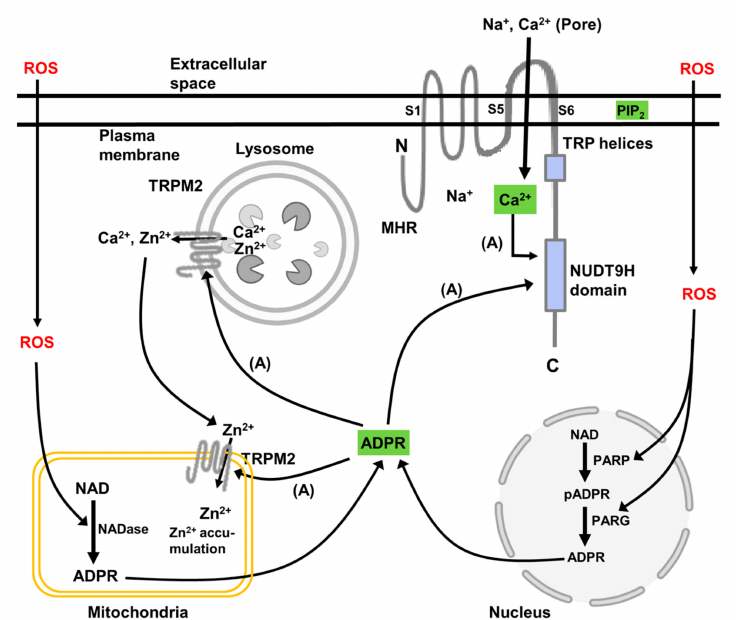
Figure 2. A schematic representation of the intracellular location of TRPM2 channels in animal cells, key functional and regulatory domains in the TRPM2 polypeptide, and the metabolic pathways leading to TRPM2 activation. The scheme shows a single polypeptide of TRPM2 whereas the functional channel is composed of four polypeptides. The domains of TRPM2 indicated are the minimal TRPM-homology region (MHR), the TRP helices, and the NUDT9 homology (NUDT9H) domain (Nudix motif). In animal cells, activation of TRPM2 is initiated by an increase in ROS, which activates poly(ADP-ribose) polymerase (PARP) and poly(ADP-ribose) glycohydrolase (PARG) in the nucleus and NAD-ase in the mitochondria. These enzymes convert NAD to poly(ADP-ribose) (pADPR) and ADP-ribose (ADPR) (shown in green). Together with Ca 2+ (green) ADP-ribose binds to the NUDT9H domain of TRPM2 and opens the channel. The activation also requires phosphatidyl inositol 4,5 bisphosphate (PIP 2 ) (green) in the plasma membrane, which is thought to interact with the basic amino acid sequences in the N-terminal MHR4 and pre-S1 domains, and in the junction between the S4 and S5 transmembrane domains and in the TRP domain. For TRPM2 in the plasma membrane, opening of the channel results in a large entry of Ca 2+ and Na + into the cytoplasmic space. For TRPM2 in lysosomes and mitochondria, it is proposed that activation of TRPM2 in lysosomes leads to release of Zn 2+ and Ca 2+ , acidification of the lumen of the lysosome, and entry of Zn 2+ into mitochondria. The information summarised is derived from studies of TRPM2 in all animal cells. Not all intracellular locations and functions have been reported for hepatocytes or other cell types in liver. (References are given in the